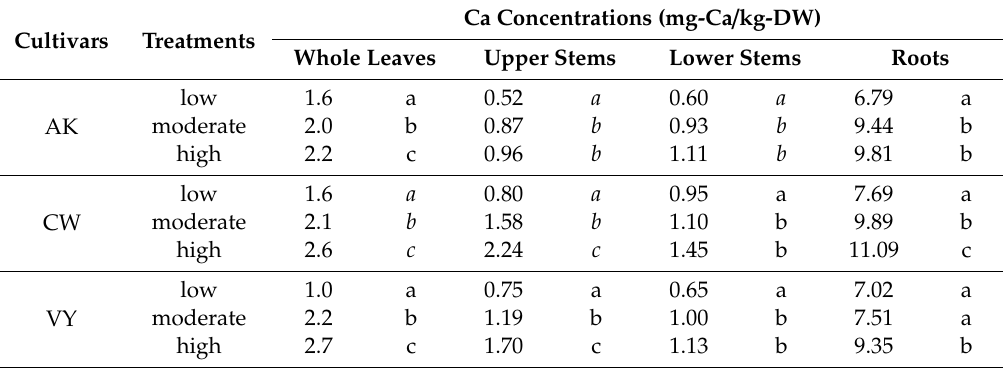
Table 3. Ca concentrations of whole leaves, upper stems, lower stems, and roots for each cultivar and treatment at the end of the experiment.